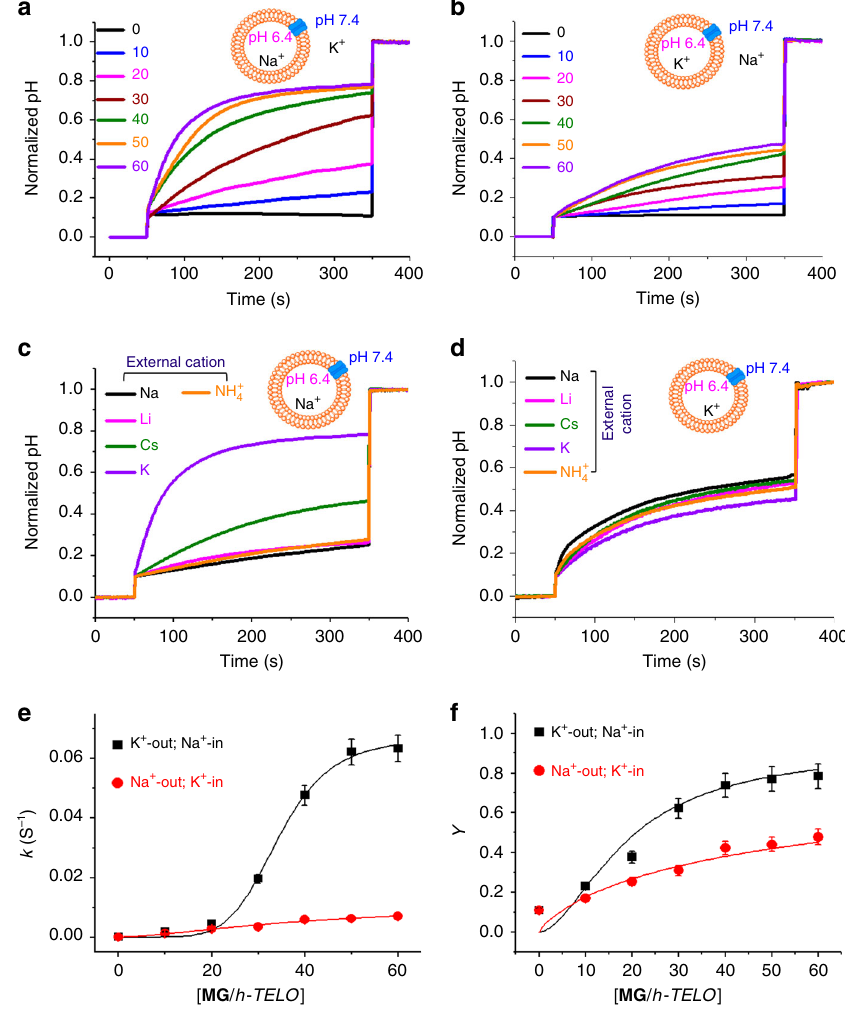
Fig. 2 Fluorescence-based ion-transport assay. Change in normalized pH inside LUV (pH in ) as a function of time with increasing addition of MG / h-TELO (0 – 60 μ M) in the presence of different metal ions and pH gradient. a Buffer composition, external: 10 mM HEPES, 100 mM KCl, pH 7.4; internal: 10 mM HEPES, 100 mM NaCl, pH 6.4. b Buffer composition, external: 10 mM HEPES, 100 mM NaCl, pH 7.4; internal: 10 mM HEPES, 100 mM KCl, pH 6.4. Change in normalized pH inside LUV as a function of time in the presence of MG / h-TELO (60 μ M) using different external metal ions. c Buffer composition, external: 10 mM HEPES, 100 mM MCl (M = Na + , Li + , Cs + , NH 4 + , and K + ), pH 7.4; internal: 10 mM HEPES, 100 mM NaCl, pH 6.4. d Buffer composition, external: 10 mM HEPES, 100 mM MCl (M = Na + , Li + , Cs + , NH4 + , and K + ), pH 7.4; internal: 10 mM HEPES, 100 mM KCl, pH 6.4. e Pseudo- fi rst-order initial constant rate as a function of fi nal concentration of MG / h-TELO in the bilayer membrane. f Fractional activity Y = f([ MG / h-TELO ]) plotted for Na + and K + ions and the curves are the best fi t from the Hill equation. Source data are provided as a Source Data fi le. Data are means ± SD ( n =